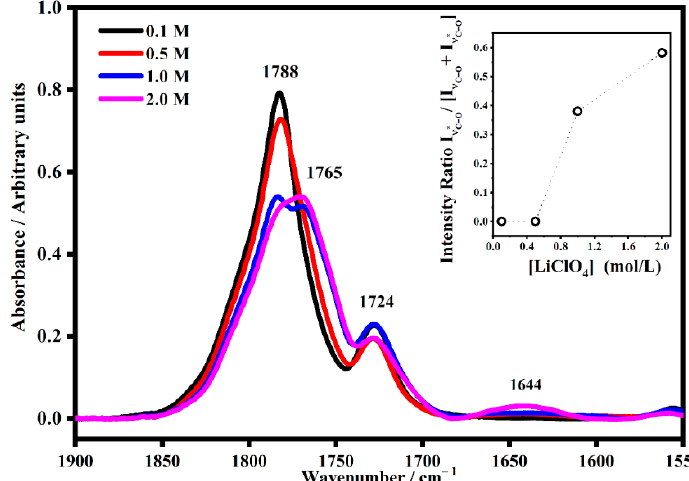
Figure 10. The IR band assigned to the C=O mode of free propylene carbonate denominated ν C=O (~1788 cm − 1 ) and its satellite band at ν C=O* (~1765 cm − 1 ) in PMMA-Li-PC gel polymer electrolyte at different salt concentrations: 0.1 M, 0.5 M, 1 M and 2 M. In the inset, the trend of the intensity ratio I ν C=O*/ [I ν C=O + I ν C=O* ] as a function of the salt concentrations.